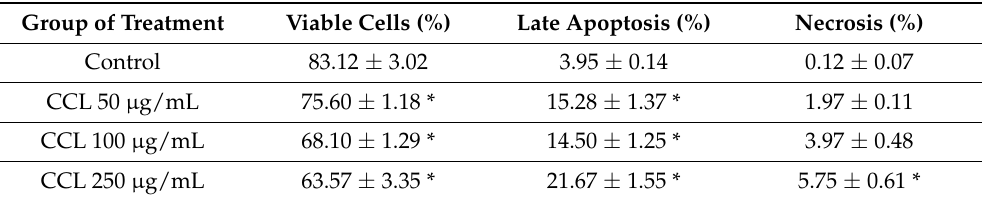
Figure 5. Flow cytometric analysis of early apoptosis, late apoptosis, and necrosis in A549 cells treated with C. chinense leaf extract. The dot plot represents the ( A ) untreated A549 cells; ( B ) A549 cells treated with 50 µ g/mL C. chinense leaf extract; ( C ) A549 cells treated with 100 µ g/mL C. chinense leaf extract, and ( D ) A549 cells treated with 250 µ g/mL C. chinense leaf extract. Table 5. The percentage of viable, late apoptosis, and necrotic cells in treatment with C. chinense leaf extract on A549